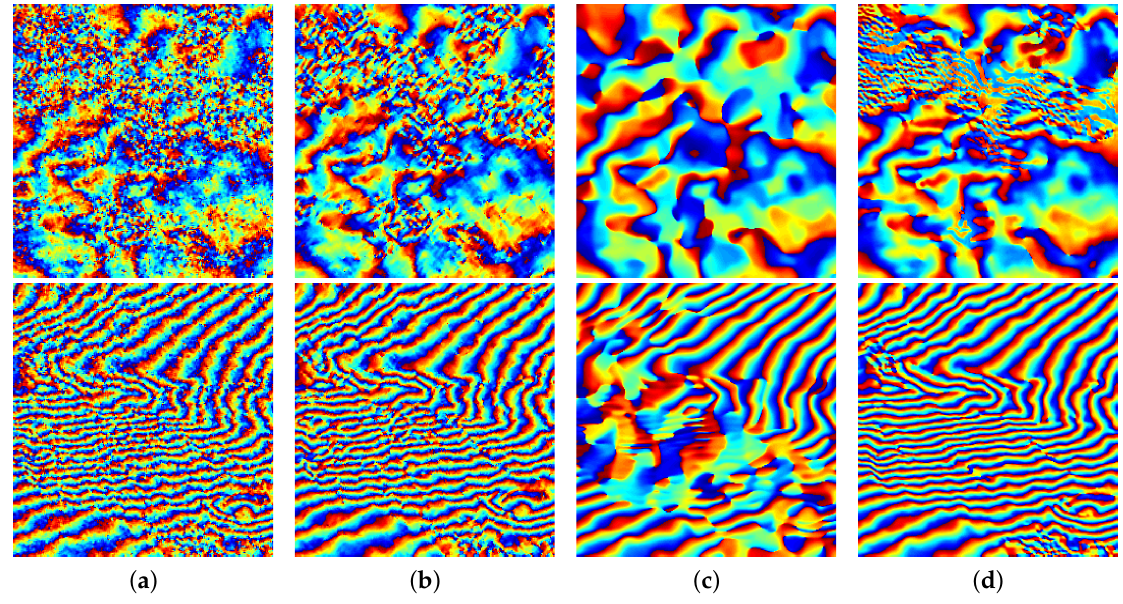
Figure 18. Filtered results of area A ( Top ) and area B ( Bottom ) using four methods. ( a ) Lee filter. ( b ) Goldstein filter. ( c ) InSAR-BM3D filter. ( d ) Proposed method. Table 5. Quantitative indexes of four methods on SIR-C/X-SAR